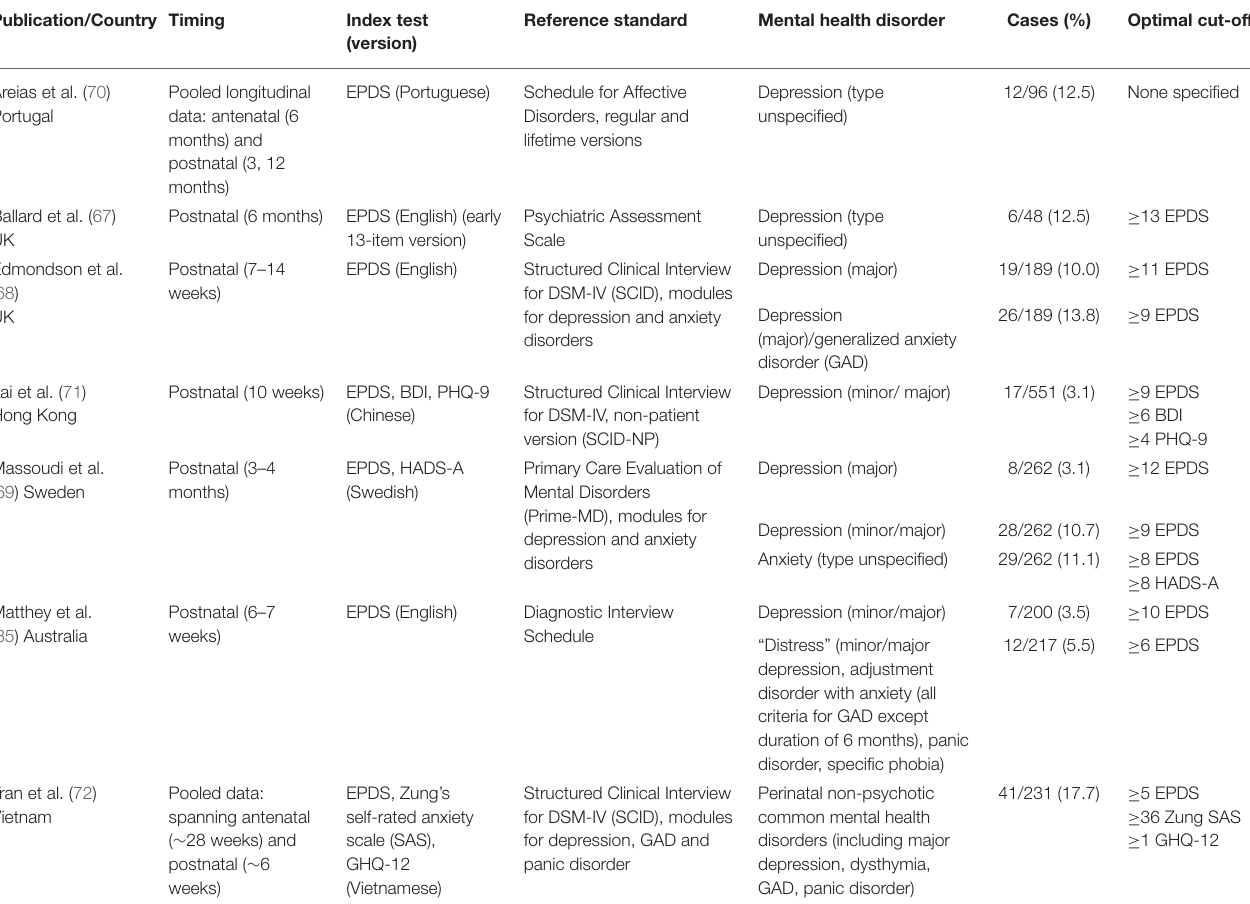
TABLE 1 | Summary of findings of included studies assessing diagnostic test accuracy in fathers ( n =